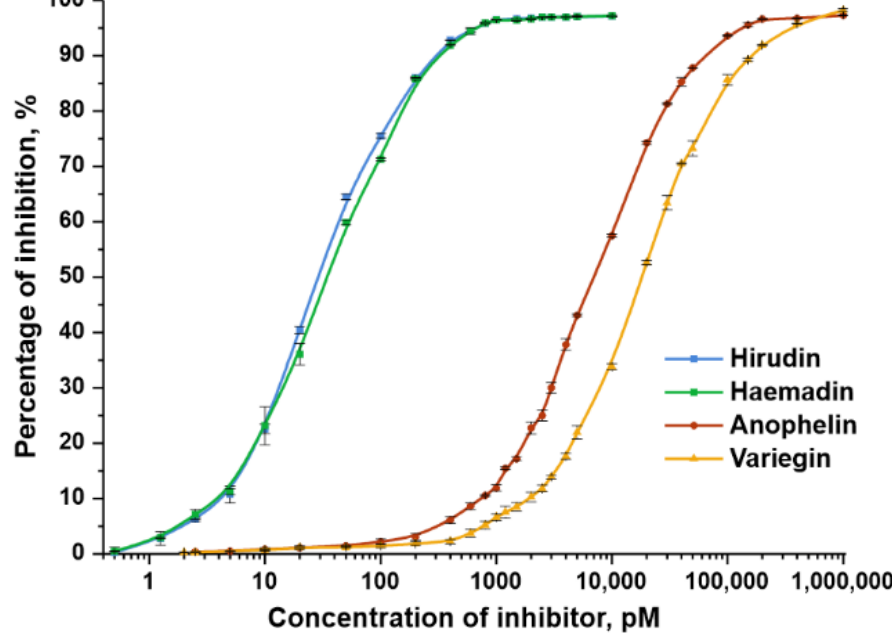
Figure 3. Dose–response curve of inhibition of amidolytic thrombin activity by hirudin-1, haemadin, anophelin, and variegin. A tight-binding assay was performed with 500 pM thrombin, 100 µ M S-2238, and different concentrations of the inhibitor.